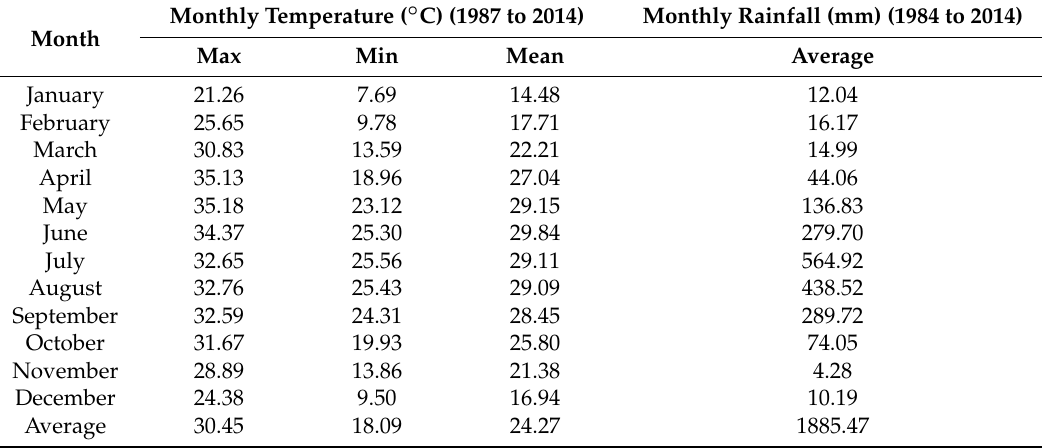
Table 2. Monthly temperature and rainfall data for nearly the past three